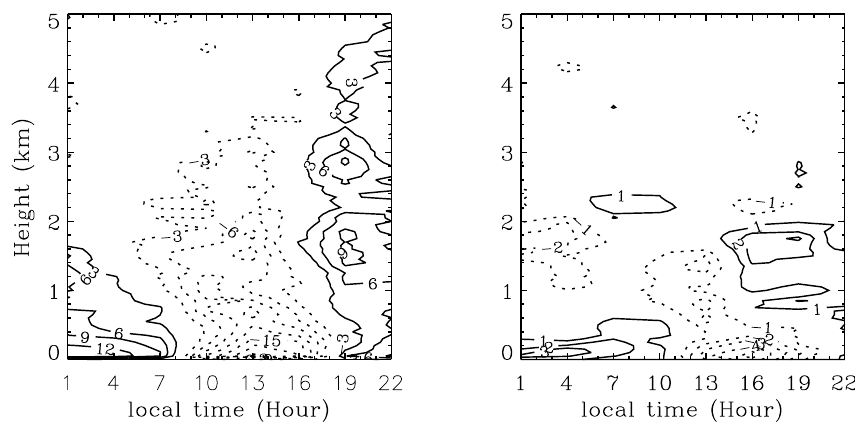
Fig. 8. Monthly-averaged local time variations of the water vapor mixing ratio disturbances in the height range from the surface up to 5km in August 2006 (left) and January 2007 (right). The solid and dotted curves denote the positive and negative values, respectively. The minimum positive values and the intervals of the contours are 3 × 10 − 4 in August 2006 and 1 × 10 − 4 in January